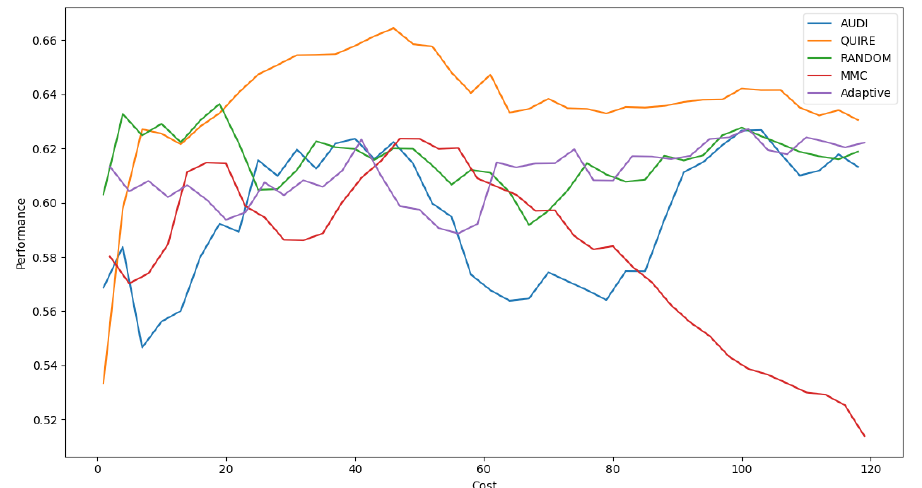
Figure 8. F1-measure for the five selection AL strategies without grid search